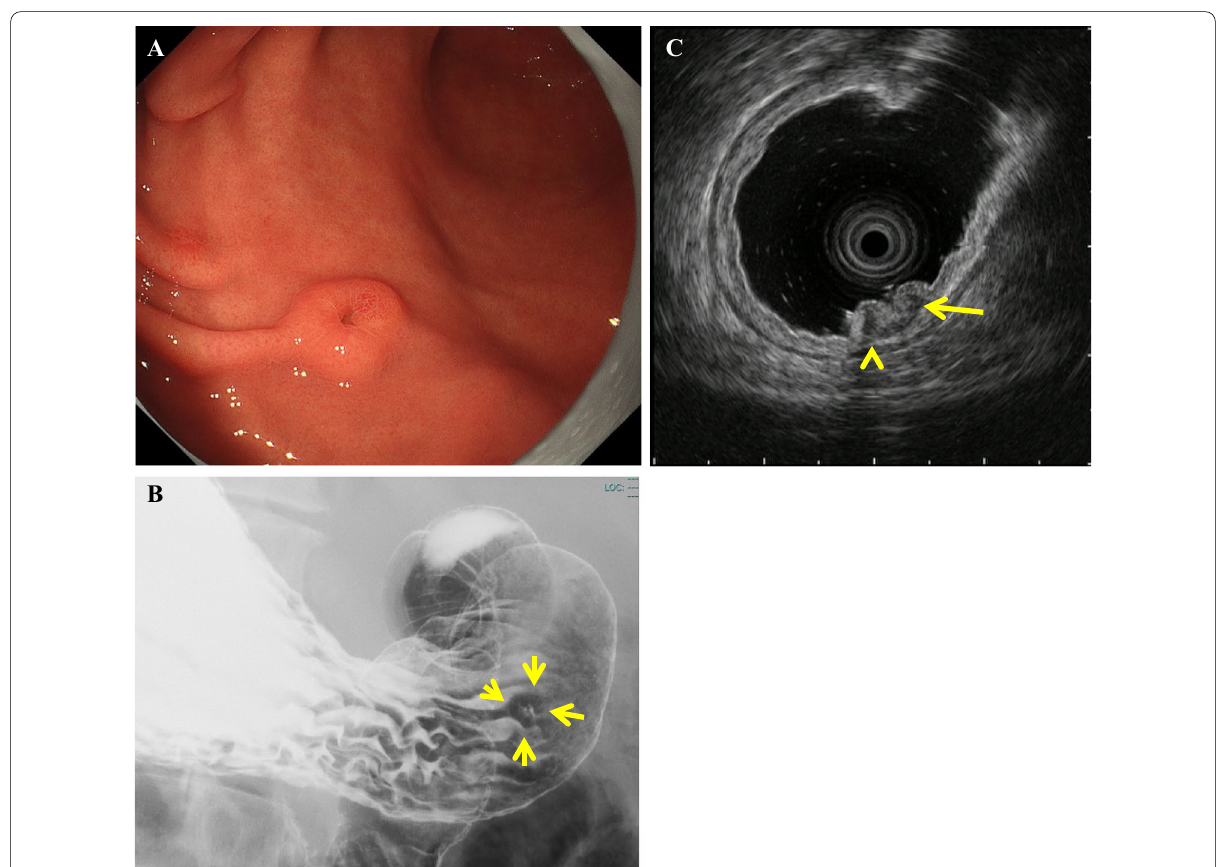
Fig. 1 A Esophagogastroduodenoscopy findings during the preoperative examination for gastric submucosal tumors. An elevated lesion, 8 mm in size, with depression in the center, covered with normal mucosa was observed in the anterior wall of the antrum. B Upper gastrointestinal series findings. A raised lesion with a central depression, 8 mm in size, was found in the greater curvature of the gastric body (arrow). C Endoscopic ultrasonography findings. A 10-mm tumor was found in the second layer (arrow). Because of the thinning of the third layer, submucosal invasion could not be completely ruled out (arrow